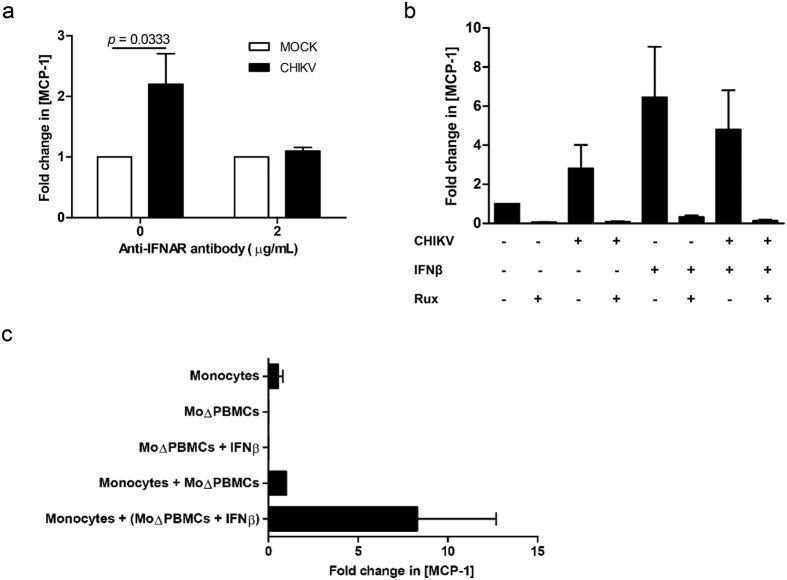
Monocytes require IFNβ-mediated communication with other leukocytes to produce MCP- 1 in response to CHIKV infection.(a) Treatment of PBMCs with αIFNAR1/2 antibody abolished CHIKV-mediated MCP-1 production. Bars represent mean + s.e.m., n = 3. (b) Treatment of PBMCs with JAK inhibitor Ruxolitinib (Rux) reduced IFNβ- and CHIKV-mediated MCP-1 production. Bars represent mean + s.e.m., n ≥ 2. (c) Addition of IFNβ-pretreated MoΔPBMCs to monocytes triggered MCP-1 production measured 24 h post co-culture. Bars represent mean + s.e.m., n = 2.